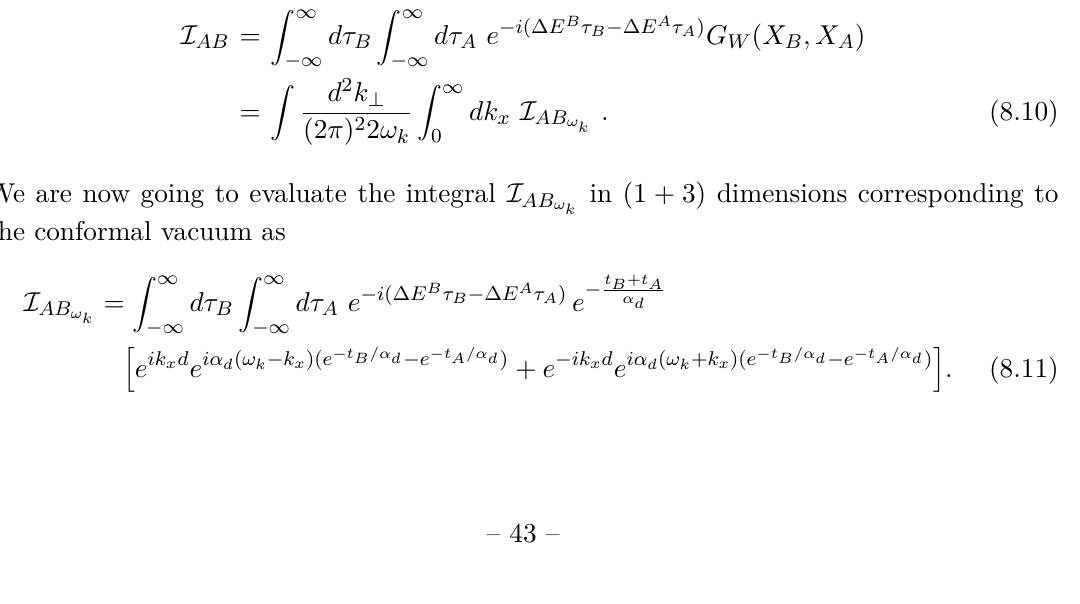
Figure 34 . The mutual information M ω as perceived by two out going null detectors is plotted with respect to the dimensionless frequency of the field modes ω